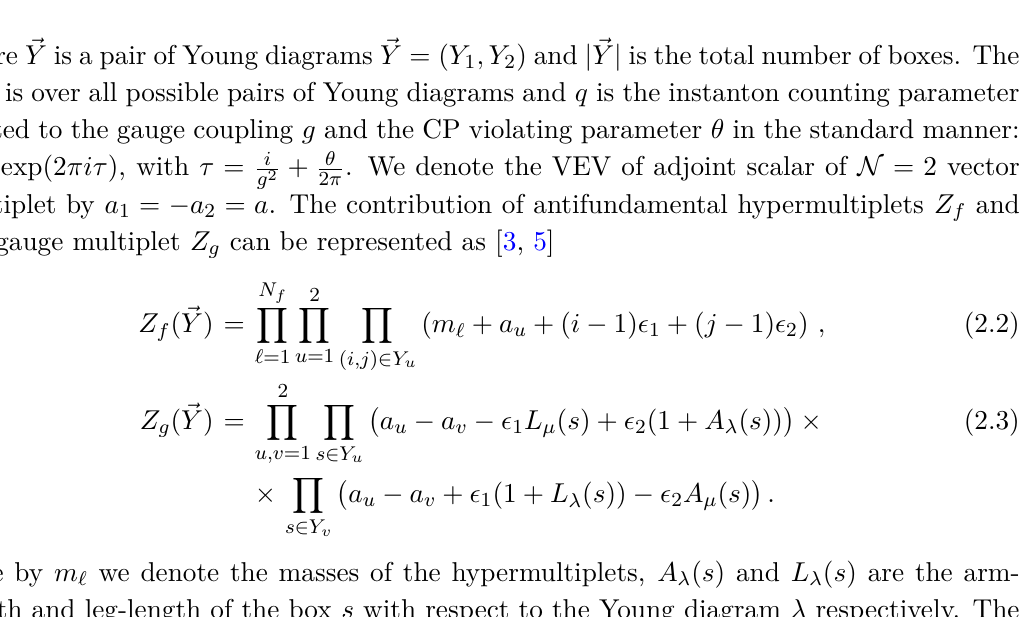
) = − 2 , L ( s ) = − 2 , A ( s ) = 2 , L ( s ) = 3 , A ( s ) = − 3 , L ( s ) = − 4 . The 1 1 2 2 3 3 is (3 , 1) 2